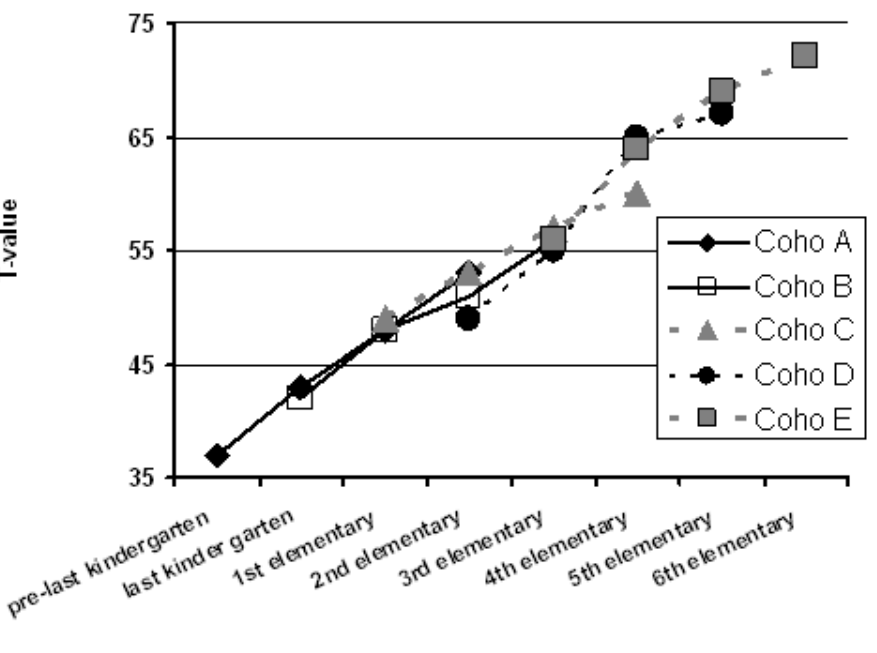
Figure 4. Cross-sequential results on general intelligence in the Luxembourg